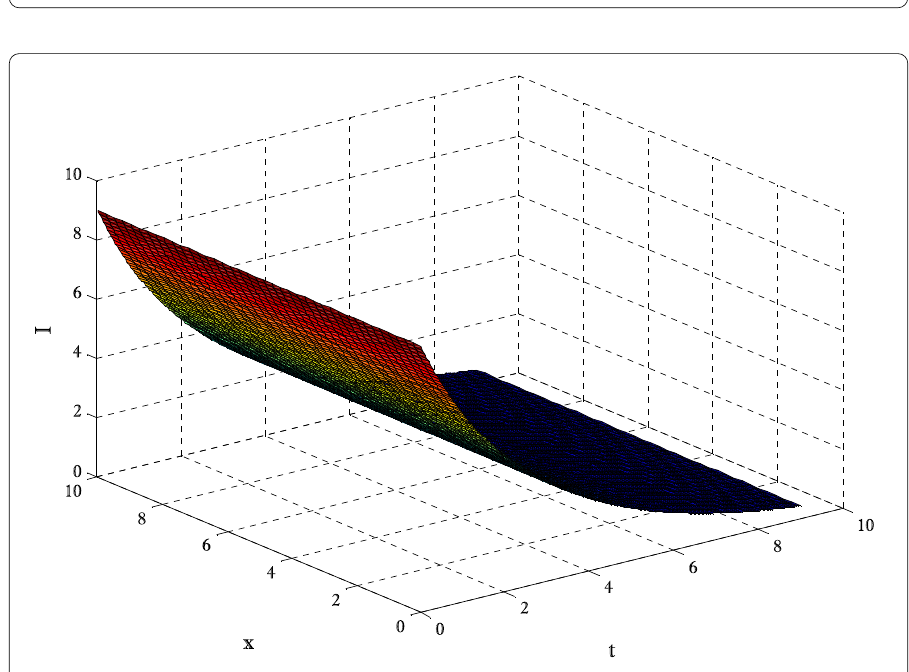
Figure 16 Surface plot for infective individuals t = 9, N x = 40, N t = 190, α = 0.1, β = 0.3, γ = 0.4, σ = 0.1, μ = 0.4,